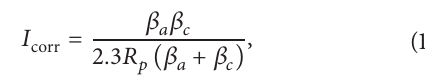
Figure 5: Evolution of 𝐸 different materials.